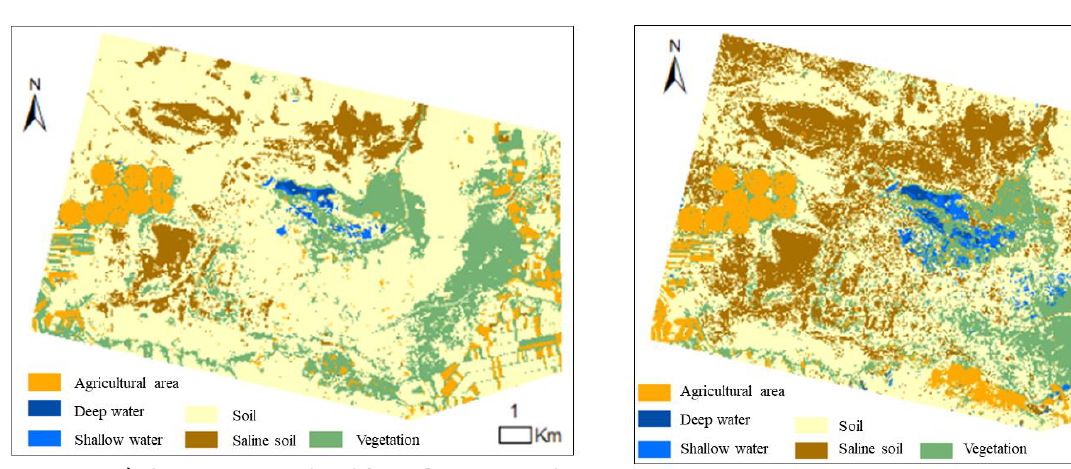
Figure 7. a) Thematic map produced from Planetscope with SVM classifier.